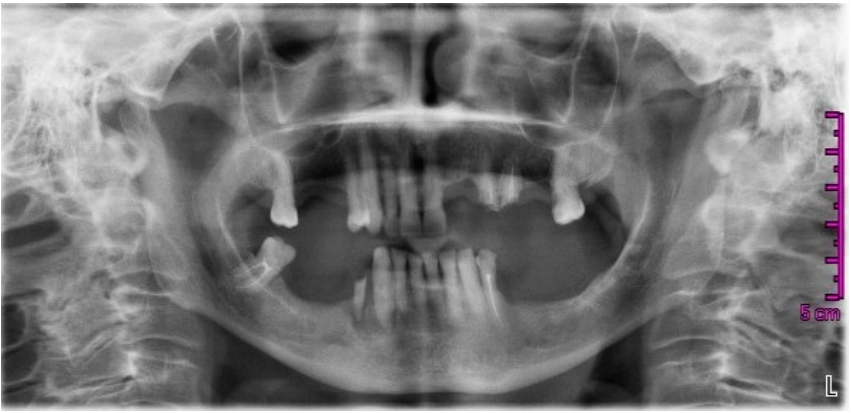
Figure 2. Orthopantomography dated March 2014.